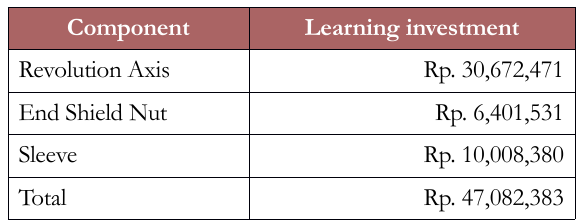
Table 19. Total learning investment